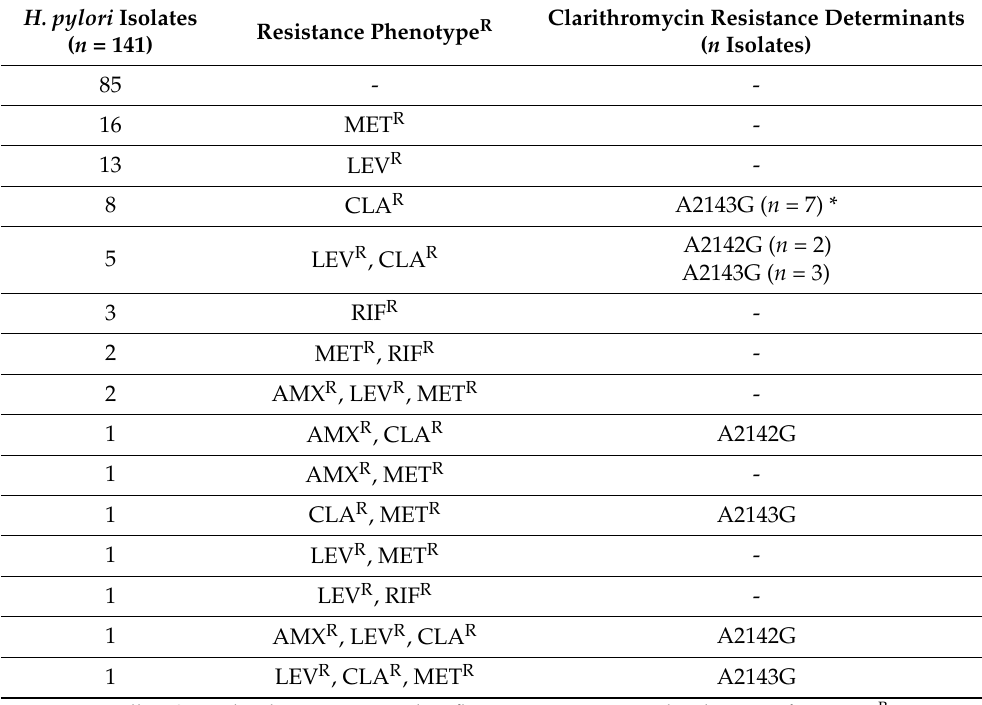
Table 1. Antibiotic resistance phenotypes and clarithromycin resistance determinants in H. pylori . H. pylori